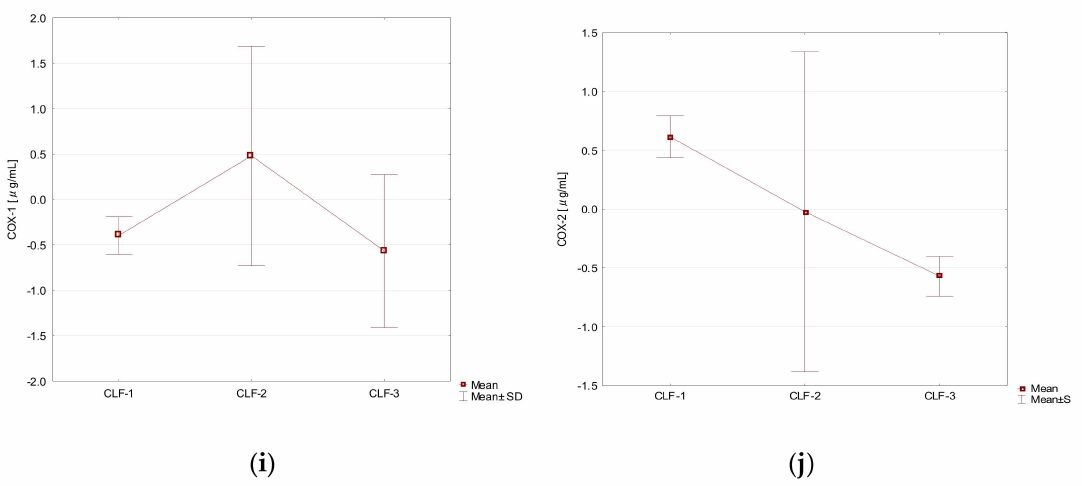
Figure 8. Box-whisker plot analysis of: ( a ) TPC, ( b ) TPAC, ( c ) TFC, ( d ) DPPH, ( e ) ABTS, ( f ) CHEL, ( g ) LPO, ( h ) HYAL, ( i ) COX-1, ( j ) COX-2 in the Cotoneaster leaves and fruits samples. Mean values ± standard deviation